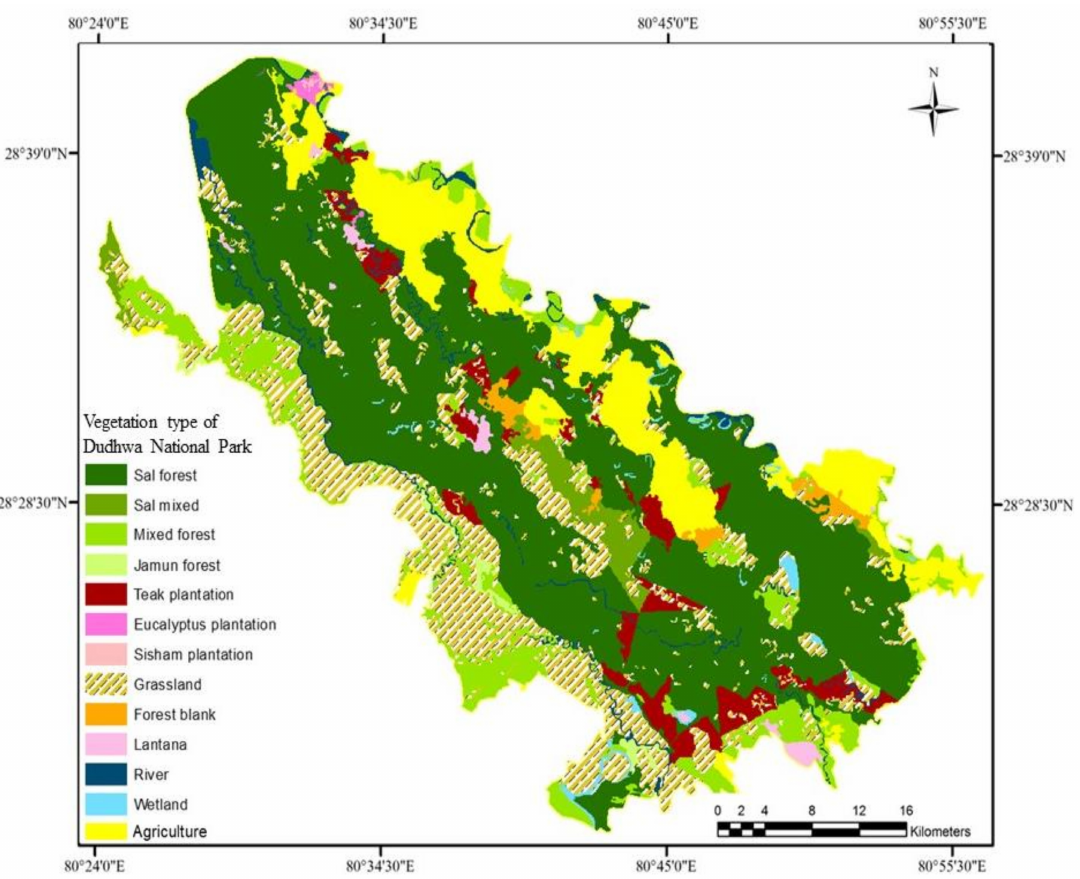
Figure 2. Forest cover map of the Dudhwa National Park.